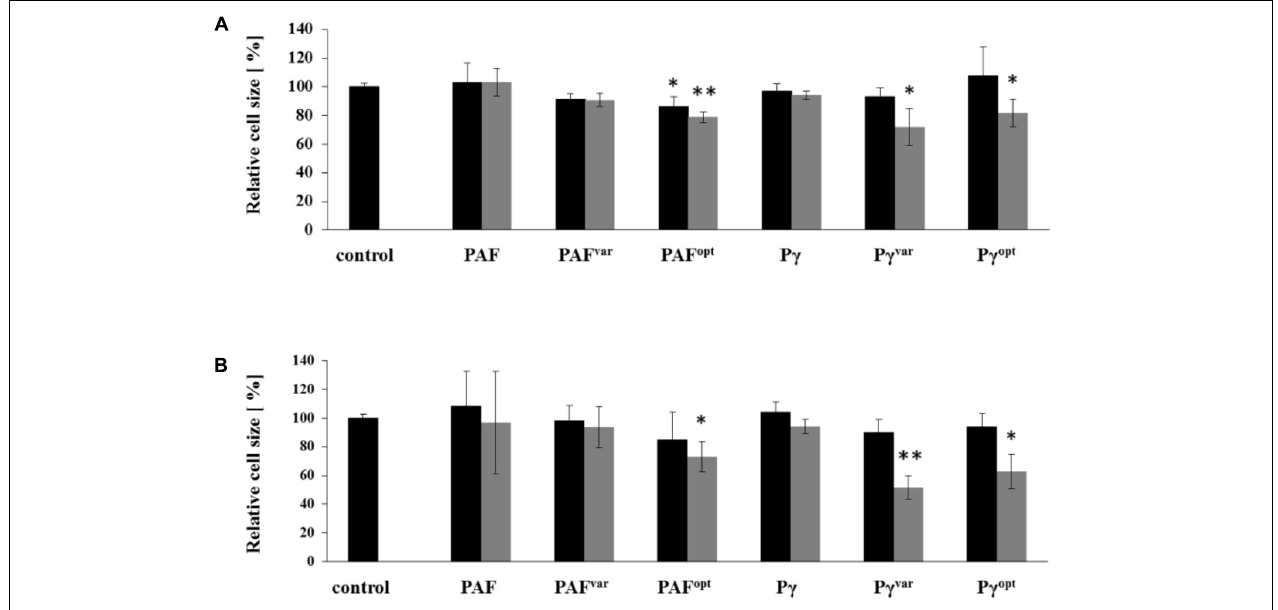
FIGURE 5 | Cell size reduction by AMPs. C. albicans cells were treated for (A) 10 and (B) 30 min with 1 × MIC (black bars) and 2 × MIC (gray bars) and analyzed by flow cytometry. The diagram shows the change in FSC values compared to untreated control cells. Values represent mean ± SD; ∗ P ≤ 0.05 and ∗∗ P ≤ 0.005.